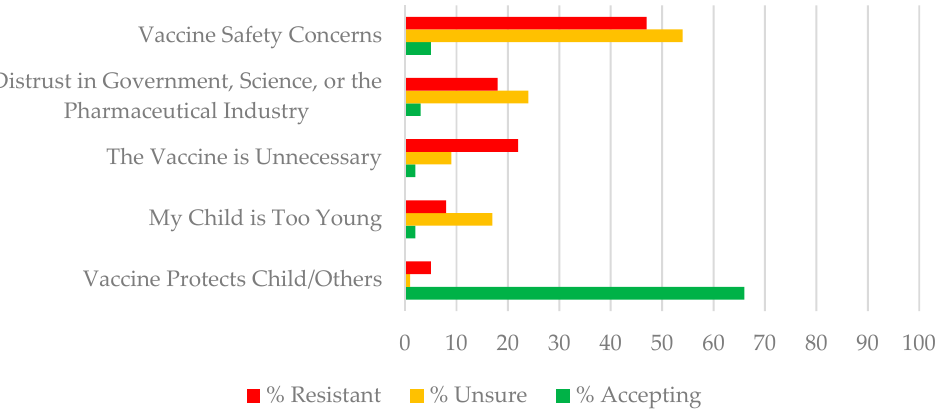
Figure 3. Percent of parents resistant, unsure, or accepting of pediatric vaccination indicating themes as the primary reasons for their decision.